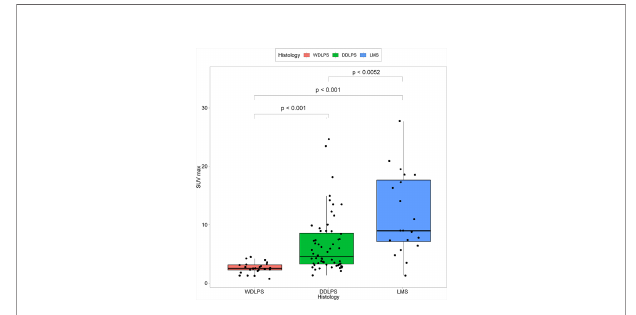
FIGURE 1 | Comparison of median SUVmax with histologic subtypes.